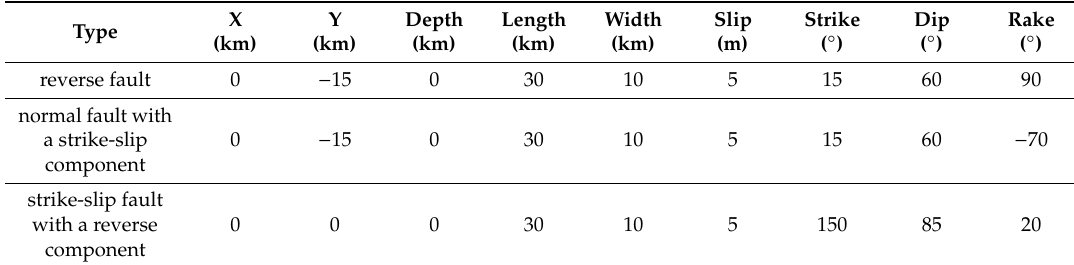
Table 1. Model parameters of reverse fault, normal fault with a strike-slip component and strike-slip fault with a reverse component.